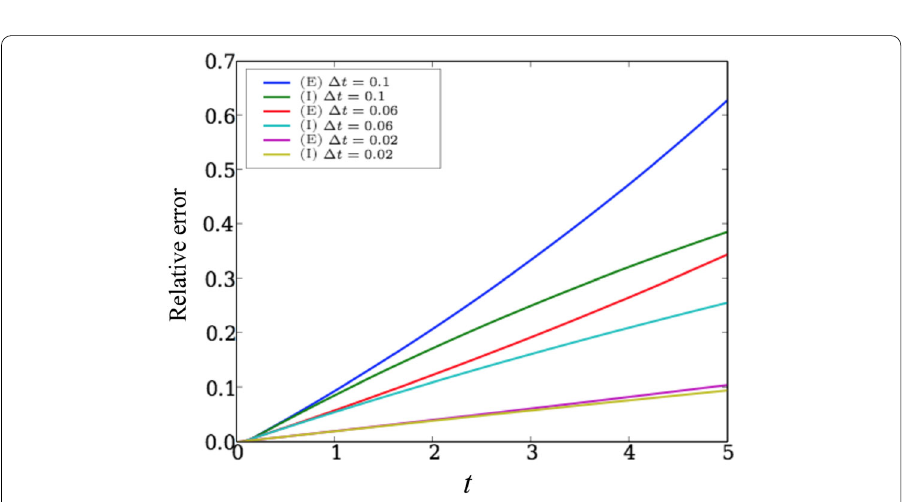
Fig. 2 Relative error of explicit (E) and implicit (I) Euler methods on the energy of the harmonic oscillator